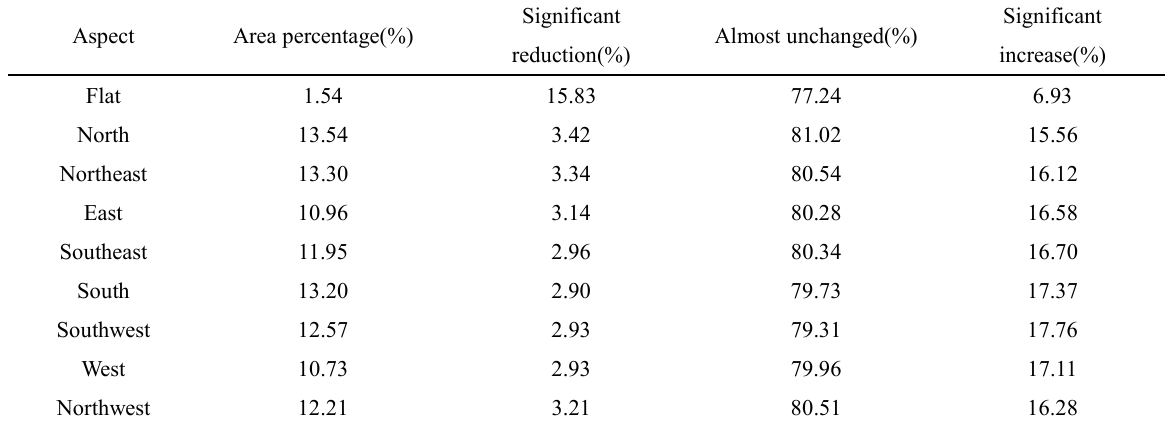
Table 4. Changes of vegetation coverage on different aspects in the source region of the Yellow